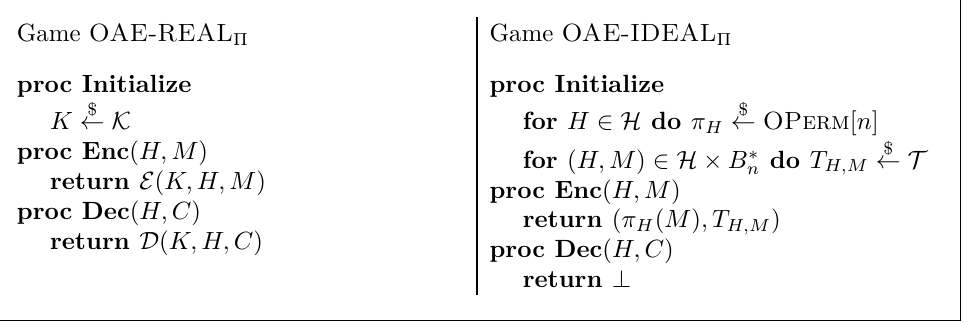
( A ) over ( t, q, b, µ )-adversaries A . Π